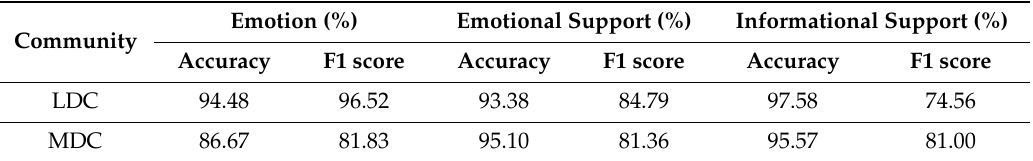
Table 2. Performance of classifier of emotion and social support in the management depression community (MDC) and lacking-management depression community